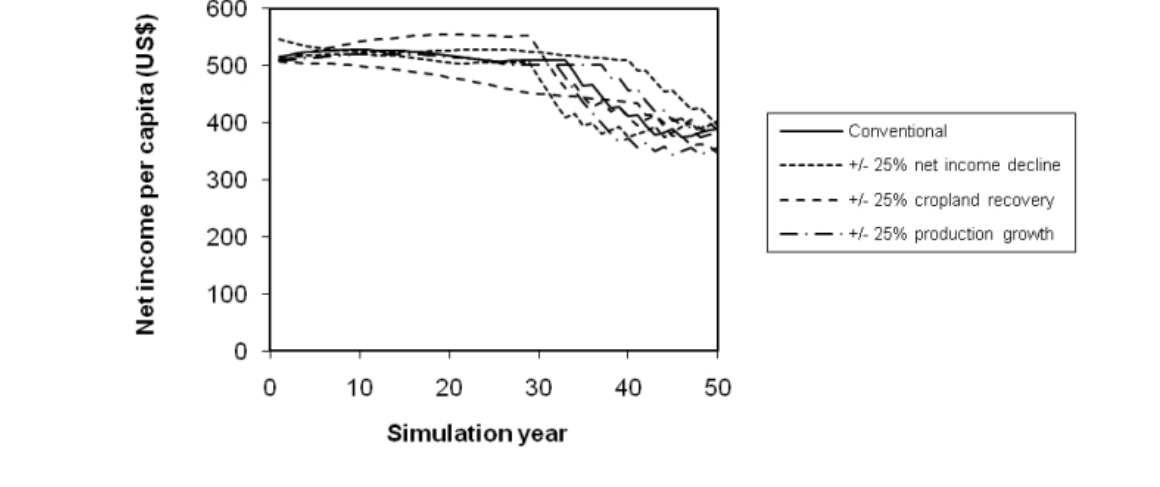
Fig. 7 . Sensitivity of simulated net income per capita under the conventional scenario to changes in net income rate, abandoned cropland reclamation rate, and agriculture production growth rate